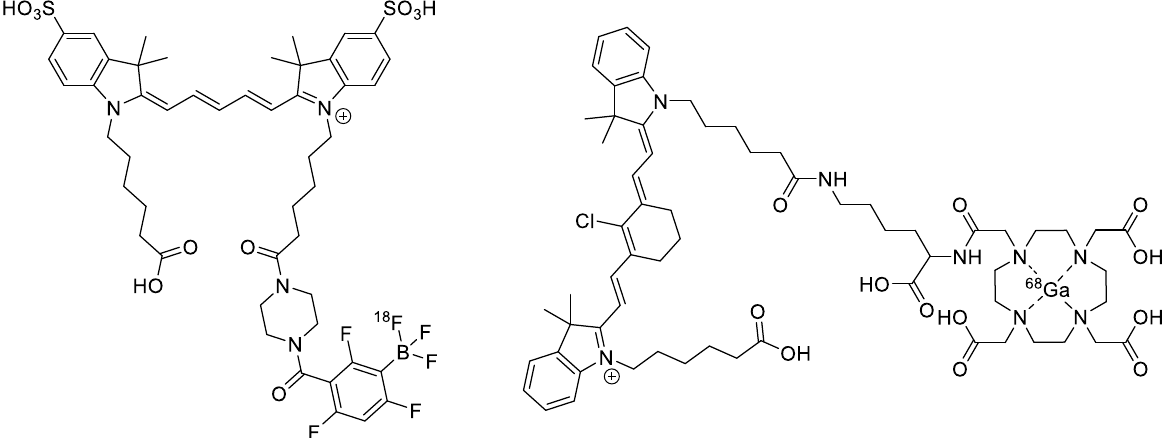
Figure 9. ( Left ) [ 18 F]Cy5-BF 3 ; ( right ) [ 68 Ga]DOTA-MHI-148 .